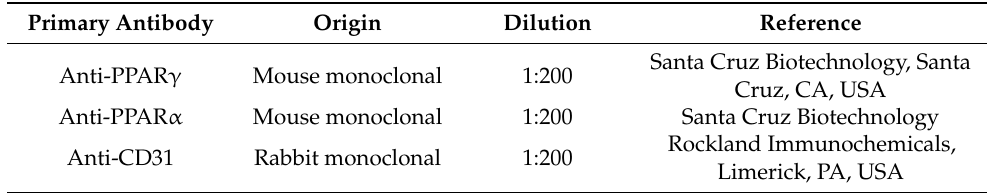
Table 3. Primary antibodies used for immunofluorescence